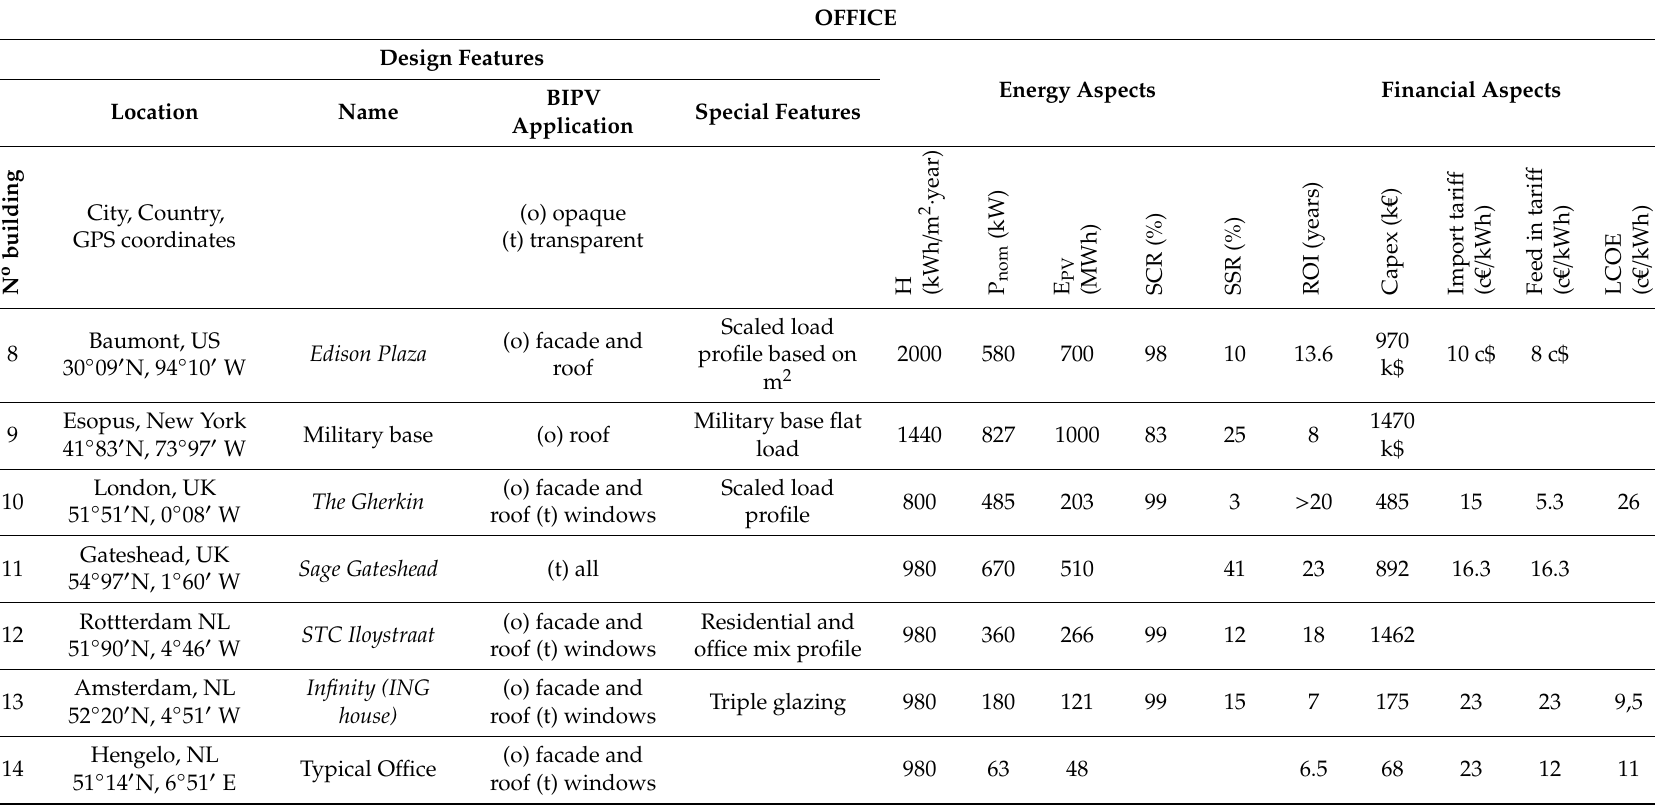
Table 3. O ffi ce building projects—design specifications and numerical results in terms of energy and financial